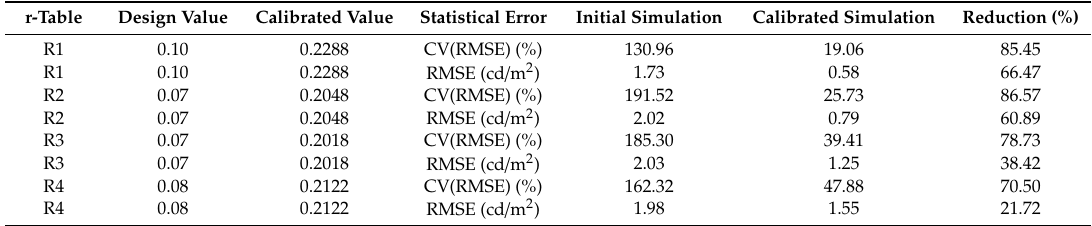
Table 6. Results of the calibration of the reduced luminance coe ffi cient for the four pavement classes of the